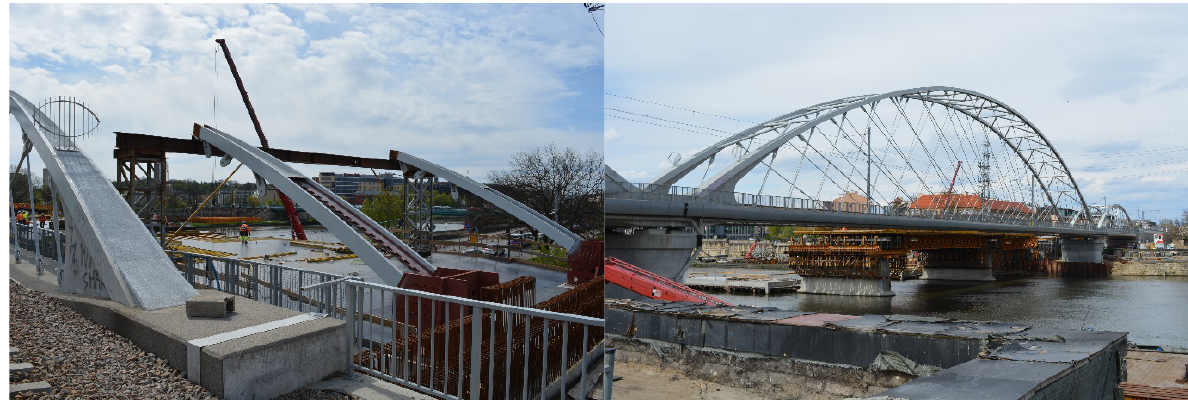
Figure 9: Scaled deformation forms from buckling and TH3 analysis.